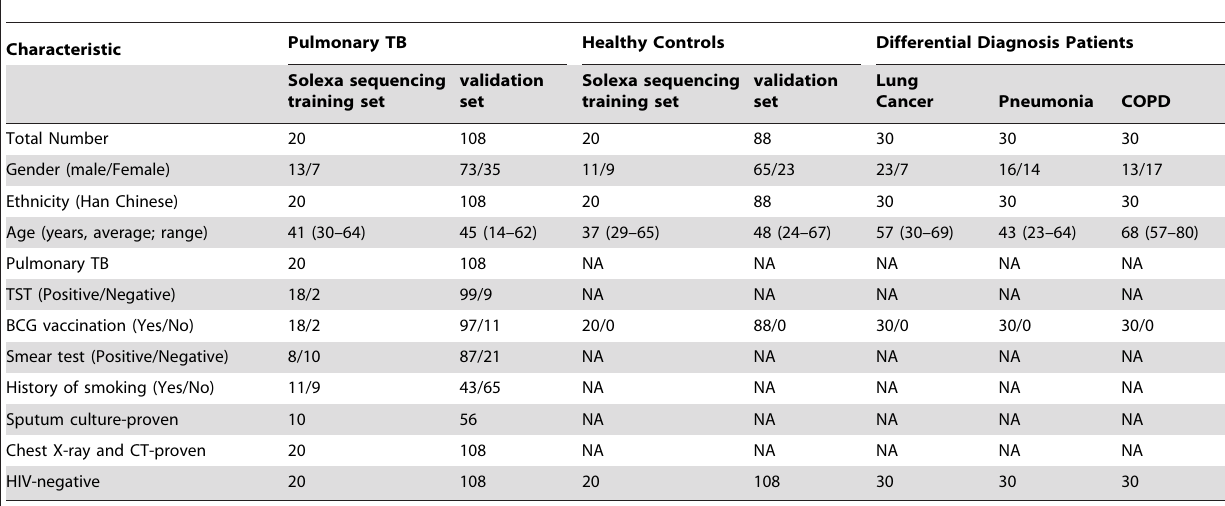
Table 1. Characteristics of study participants with pulmonary TB, healthy controls, lung cancer, pneumonia and COPD.